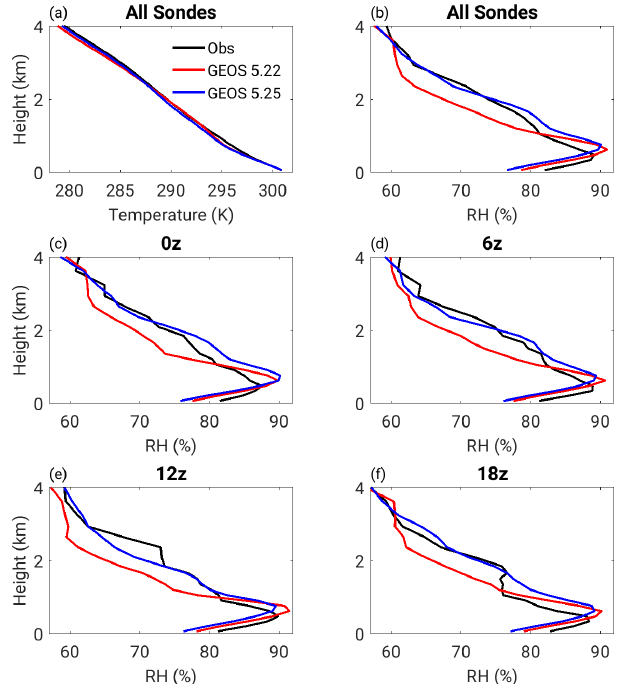
Figure 1. Vertical profile of (a) temperature and (b) relative hu- midity biases with respect to all PISTON sonde relative humidities at (c) 00:00Z (0z), (d) 06:00Z (6z), (e) 12:00Z (12z), and (f) 18:00Z (18z) from the PISTON sondes GEOS 5.22 and GEOS